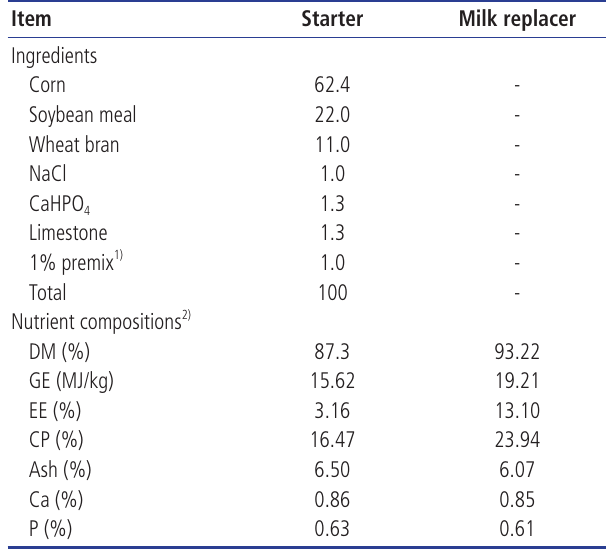
Table 1. Composition and analysis of a calf starter on DM basis Item